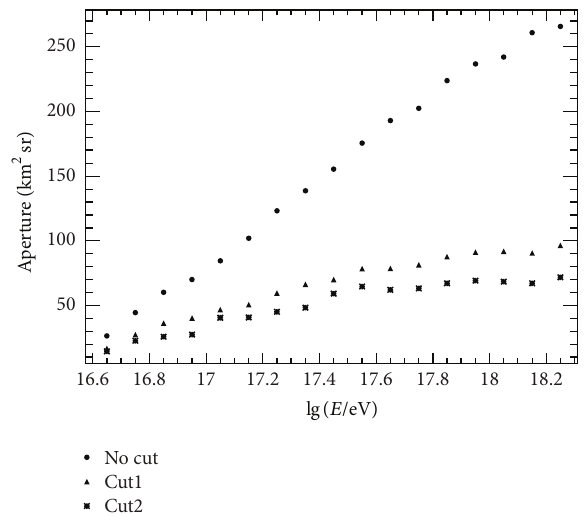
Figure 5: A typical air shower seen by the WFCTA fluorescence detectors. Each square marked with a number shows the FOV of each telescope. The open circles in the square represent triggered tubes and the size of each circle is proportional to logarithm of the number of photons. The solid curve crossing the circles represents theprojection ofa planecontaining theshoweraxis andthedetector. Energy (in PeV) and zenith and azimuth angle (in degrees) are displayed at the top.